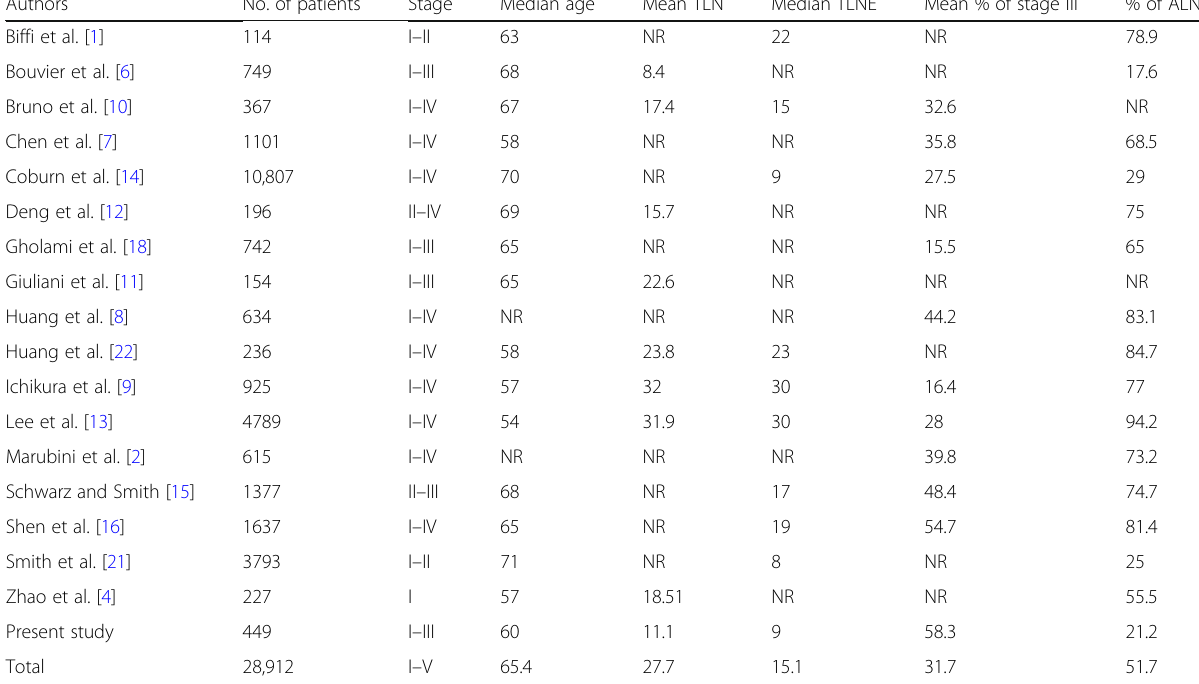
Table 5 The status of lymph nodes assessment in resected gastric adenocarcinoma in major reported series in the